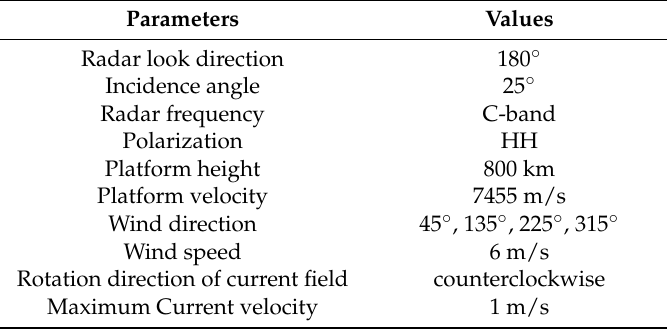
Table 6. The simulation parameters of Figure 14.